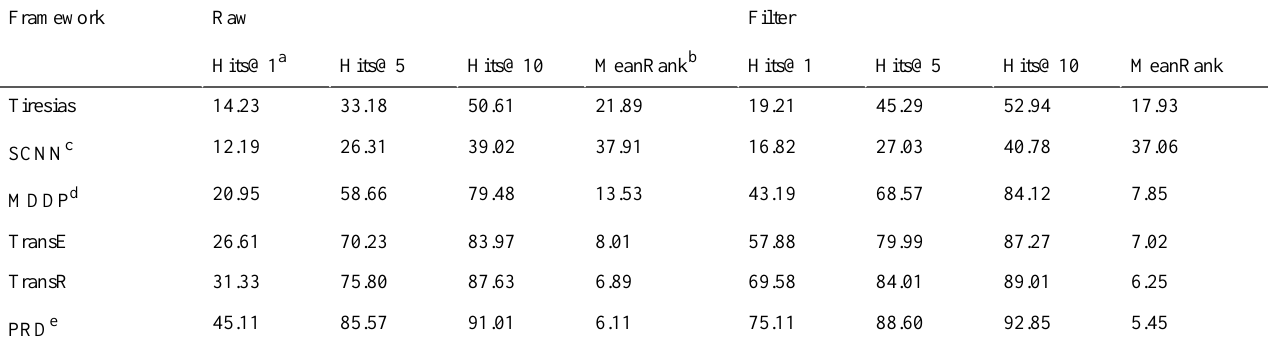
Table 2. Evaluation results for multiple drug-drug interaction relation predictions (×100 for Hits@k).